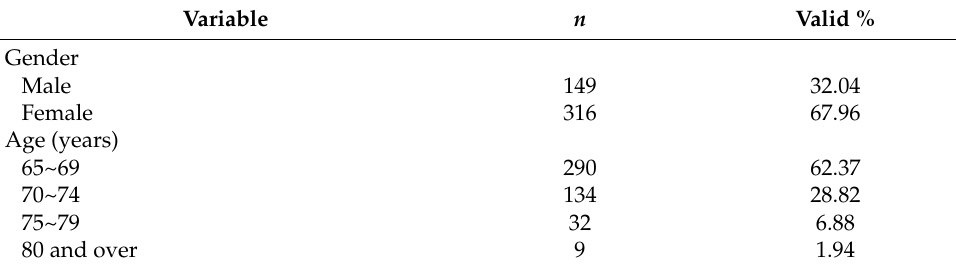
Table 1. Demographic and socioeconomic